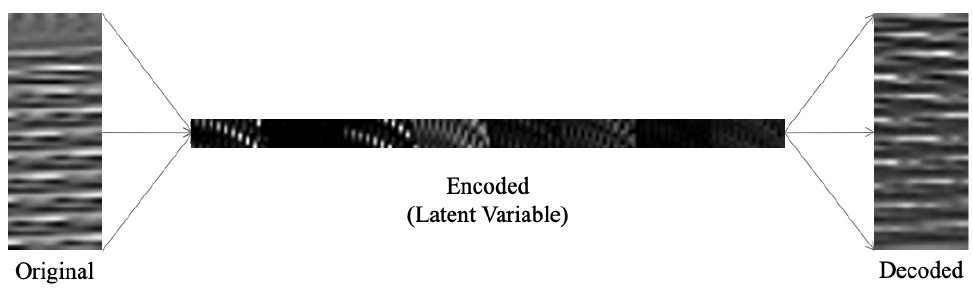
Figure 5. Original and decoded voice data samples.